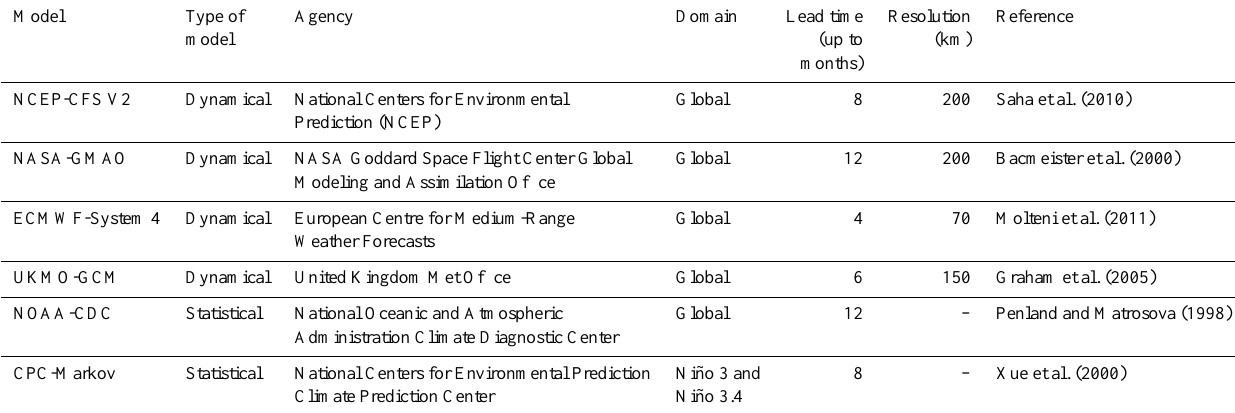
Table A1. Summary of some available forecast models of the sea surface